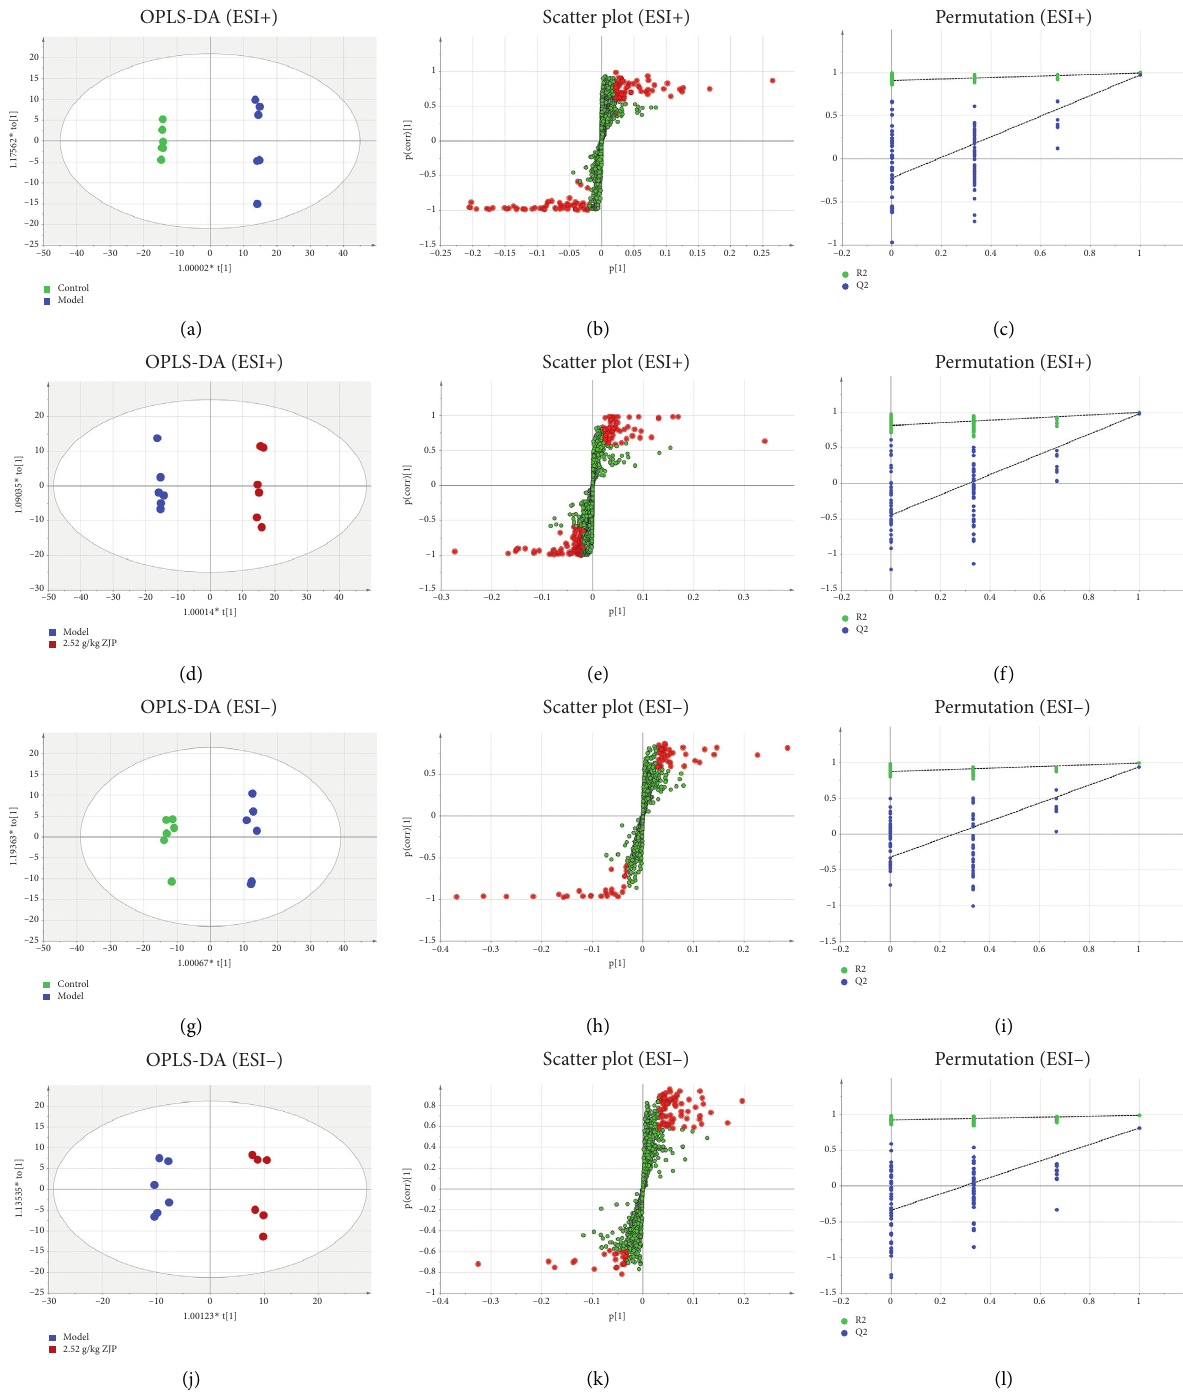
Figure 4: The OPLS-DA score plots, S-plot, and 100-permutation test generated of serum samples between the control group, model group, and 2.52g/kg ZJP group. OPLS-DA score plots were the pairwise comparisons in ESI+ mode, (a) control group versus model group and (d) model group versus 2.52g/kg ZJP group, as well as in ESI − mode, (g) control group versus model group and (j) model group versus 2.52 g/kg ZJP group. S-plot of the OPLS-DA model in ESI+ mode, (b) control group versus model group and (e) model group versus 2.52g/kg ZJP group, as well as in ESI − mode, (h) control group versus model group and (k) model group versus 2.52g/kg ZJP group. (c) The 100- permutation test of the OPLS-DA model in ESI+ mode, control group versus model group and (f) model group versus 2.52 g/kg ZJP group, as well as in ESI − mode, (i) control group versus model group and (l) model group versus 2.52g/kg ZJP